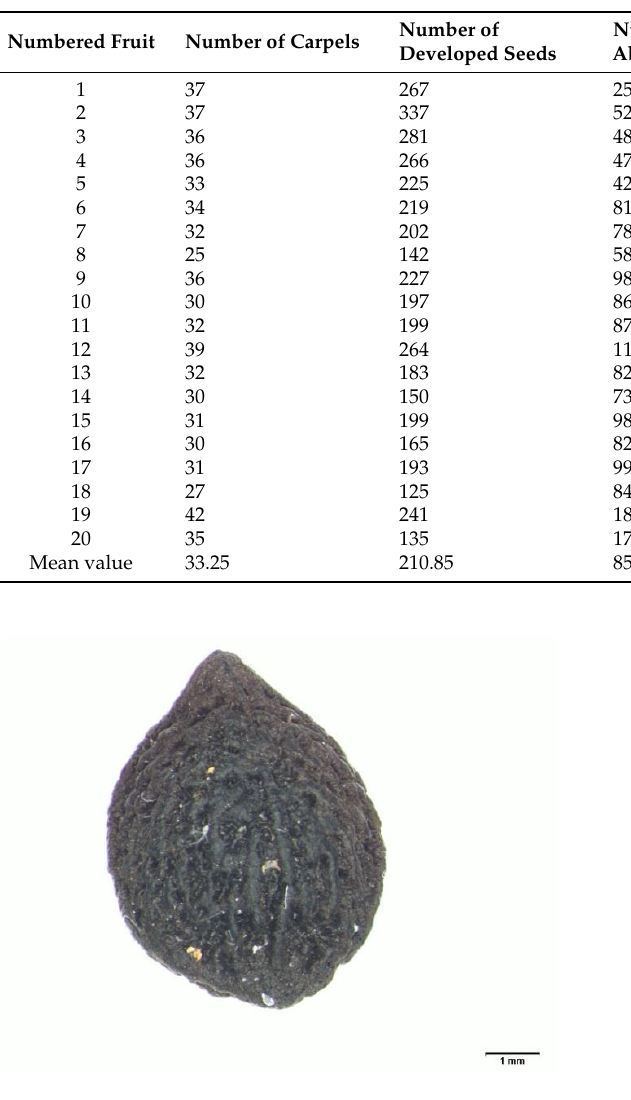
Figure 1. Seed appearance of Manglietia crassipes . Seed size (including the exotesta) of M. crassipes was 5–7 × 4–5 mm. Its thousand seed weight was 36.6 g (derived from the mean weight of 100 seeds with eight replicates at 3.66 g), and the coefficient of variation (CV) was 1.524, which is ≤